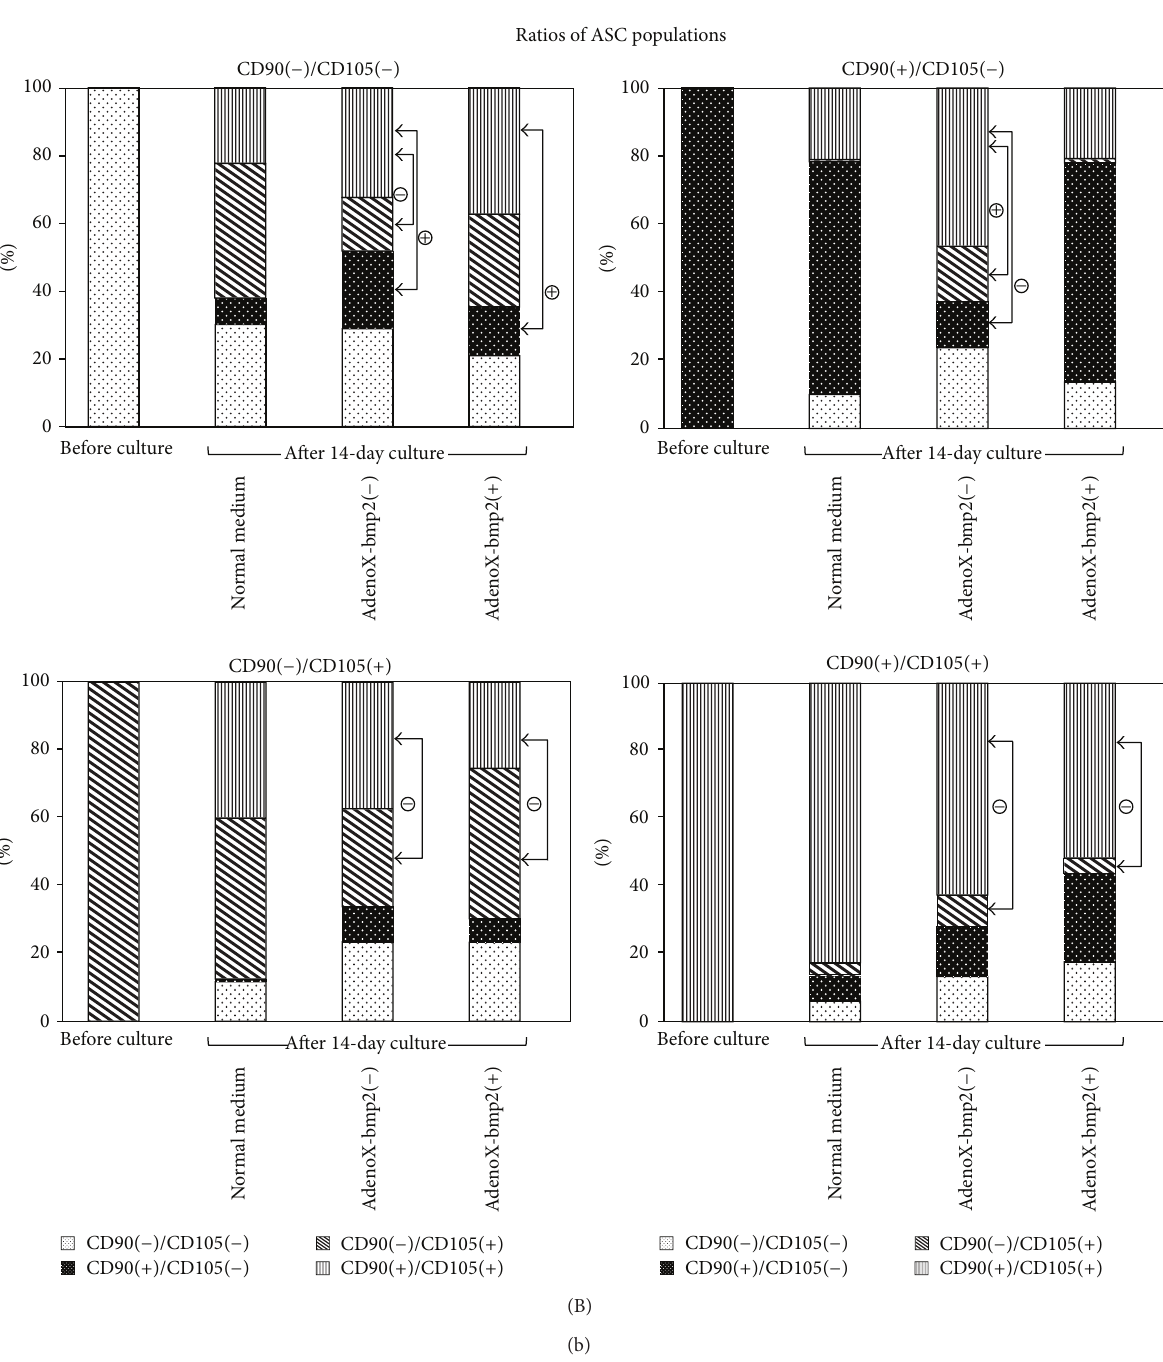
Figure 3: FACS analysis. (A) (a) ASCs at the second passage were separated into four populations: CD90( − )/CD105( − ) (green), CD90(+)/CD105( − ) (light blue), CD90( − )/CD105(+) (dark blue), and CD90(+)/CD105(+) (brown). ASCs pink in color were not categorized with any group. ((b)–(e)) ASCs were cultured in DMEM without osteogenic supplements (normal), ((f)–(i)) ASCs were cultured in osteogenic medium (AdenoX-bmp2( − )), whereas ((j)–(m)) ASCs were also transfected with AdenoX-bmp2 (AdenoX-bmp2(+)). (B) Ratios of the populations of the sorted ASCs altered in the three different culture media after 14-day culture, which resulted in changes of percentages of cells positive for CD90 or CD105: CD90(+)/CD105( − ) plus CD90(+)/CD105(+) as CD90-positive, and CD90( − )/CD105(+) plus CD90(+)/CD105(+) as CD105-positive. The results are expressed as means of three replicates using three different batches of ASCs. Statistical significance was identified as follows: ⊖ , decreased compared to that in normal medium of 14-day culture; ⊕ , increased compared to that in normal medium of 14-day culture ( 𝑃 < 0.05